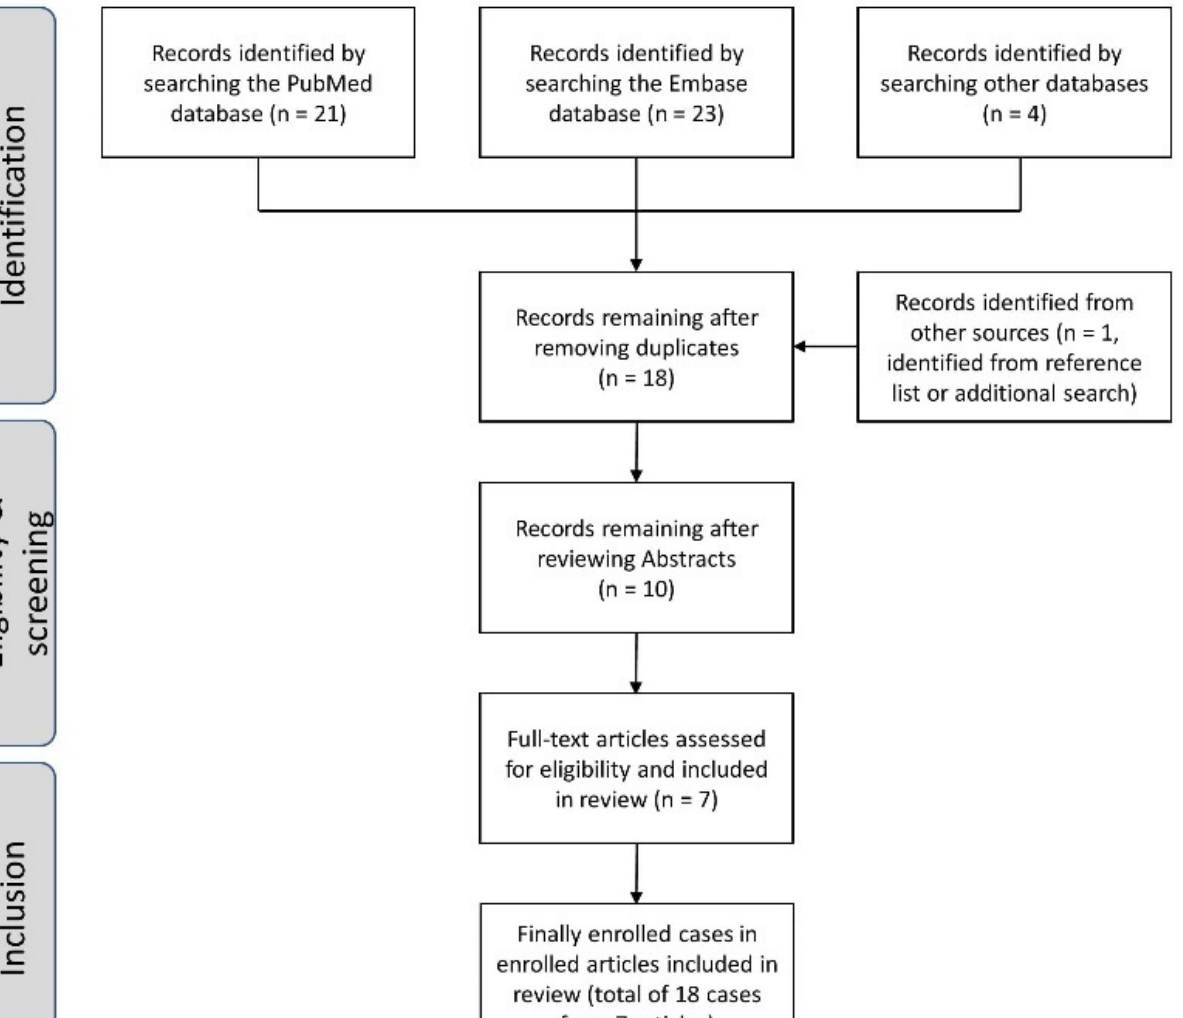
Table 1. Summary of enrolled studies.